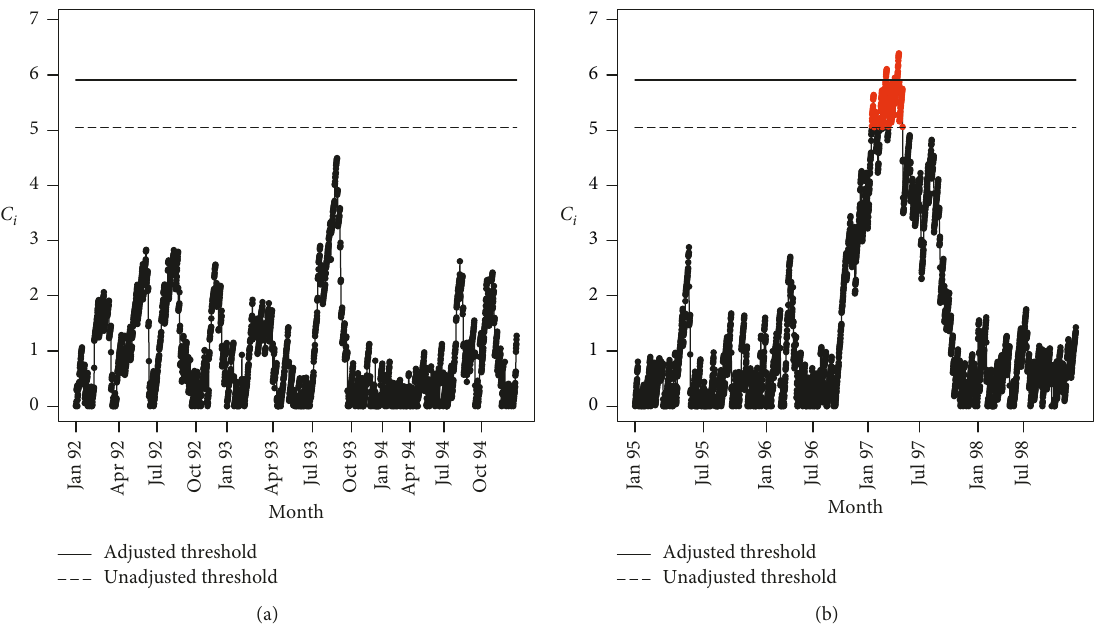
Figure 4: RA-CUSUM chart for Phase-I and Phase-II assuming first three years as the Phase-I for 30 days mortality of cardiac surgery patients. (a) Phase-I chart, unadjusted UCL � 5.047 and adjusted UCL � 5.899. (b) Phase-II chart, unadjusted UCL � 5.047 and adjusted UCL � Figure 10(b) indicates the risk-adjusted EWMA chart for